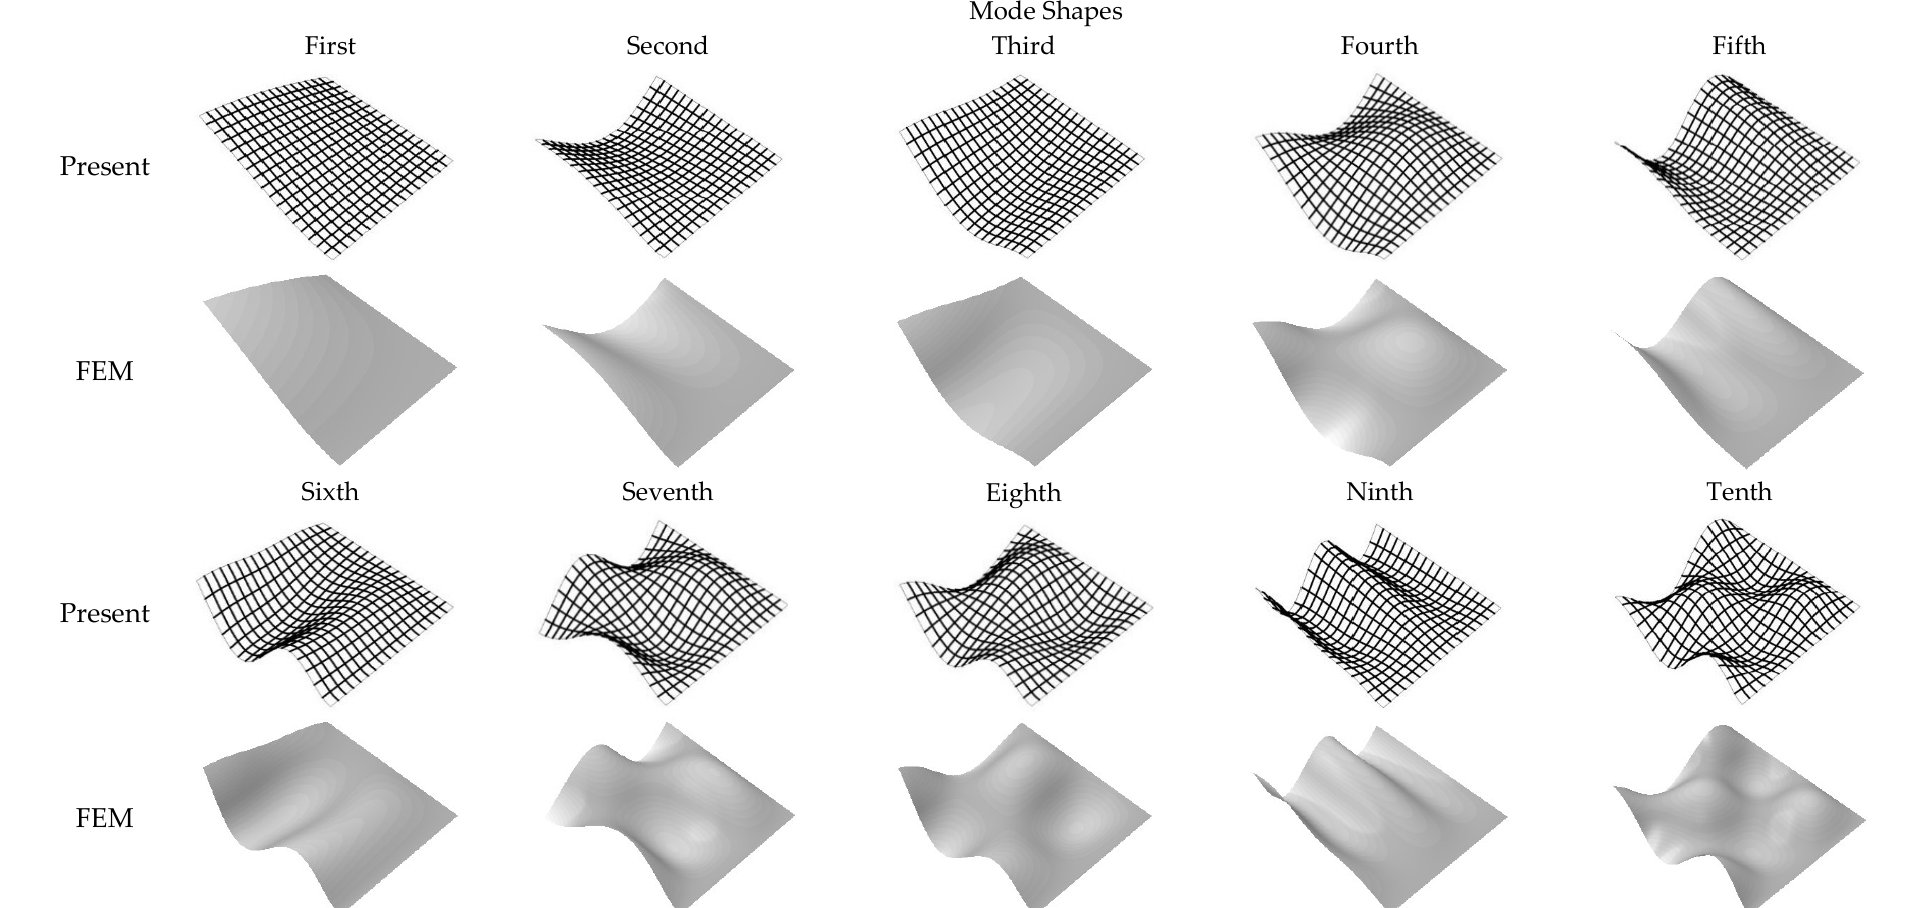
Figure 3. First ten mode shapes of the square CSFF thin plate with µ = 0.3 , r x 0 = 0.999999 and r y 0 = 0.000001 .